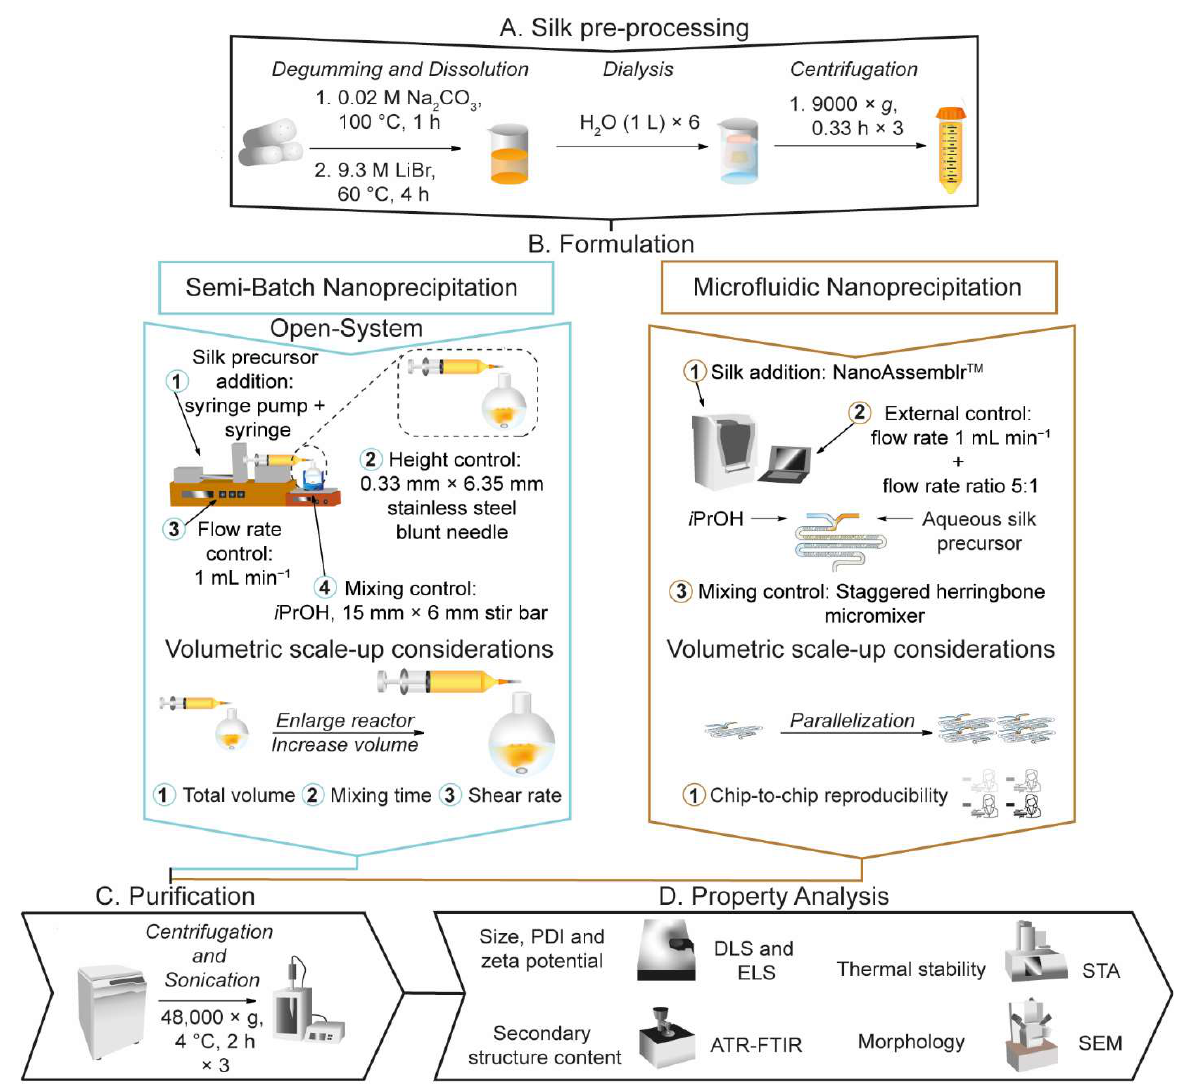
Figure 1. The nanoprecipitation workflow for the manufacture of silk nanoparticles in semi-batch and microfluidic formats by antisolvent-induced desolvation in isopropanol and the volumetric scale-up considerations explored in this study. The formulation process consisted of four steps in semi-batch format: (1) preparation of an aqueous silk precursor solution in a syringe equipped with a blunt needle, ensuring the silk precursor is free of bubbles; (2) fixing the needle to standardize the feed position of the silk precursor; (3) addition of the silk precursor to the antisolvent at a fixed flow rate; and (4) control of the stirring rate and mixing time during addition of the silk precursor to the antisolvent. The formulation process consisted of three steps in microfluidic format: (1) preparation of aqueous silk precursor solution and antisolvent syringes, ensuring the syringes are free of bubbles for loading into a NanoAssemblr TM microfluidic chip; (2) remote control of the flow rate ratio of isopropanol:silk precursor; and (3) remote control of the mixing time via the total flow rate. To aid the translation from lab- to pilot-scale equipment, the flow properties of the semi-batch system were first characterized (Figure 2, Tables S1–S3, Supplementary Materials). The silk molecules within the free-falling droplets were mixed mainly by convection, due to the high fluid velocities compared to the diffusion coefficient (Figure 2a, Table S3). Consequently, the silk concentration within the droplets and the solvent-antisolvent mixing efficiency across the surface of the droplets could be considered as uniform.